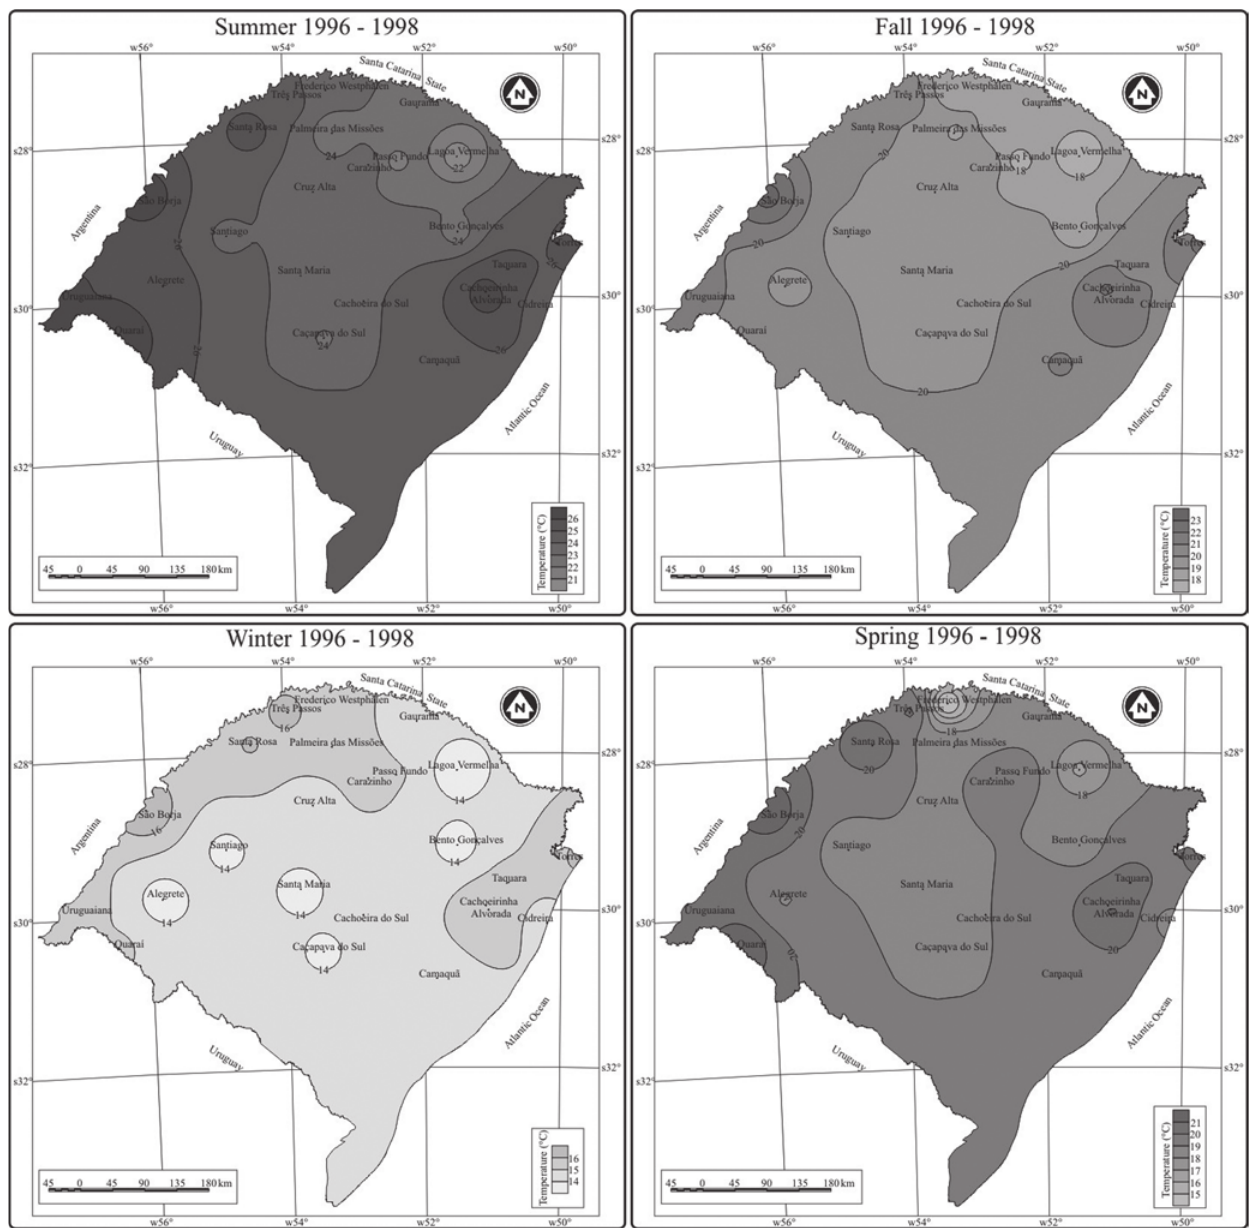
Fig. 1. Mean water temperature in several cities of the state of Rio Grande do Sul from 1996 to 1998 (Source